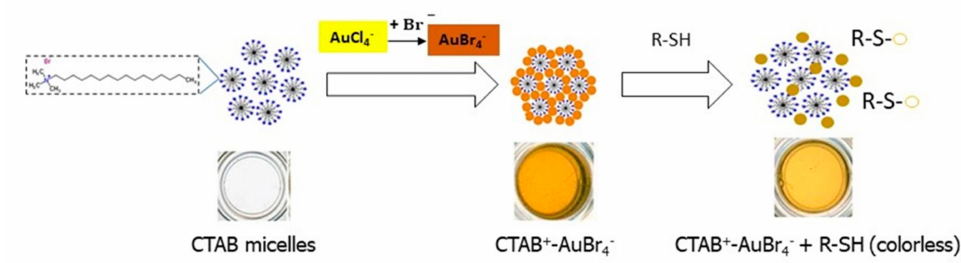
Figure 2. Graphical representation of the potential mechanism of biothiol sensing using gold-coated CTAB micellar